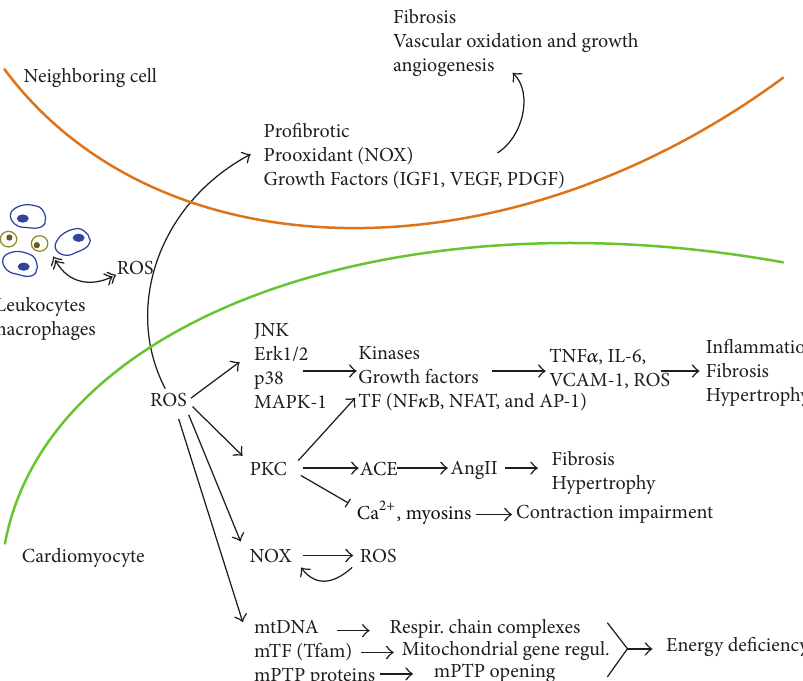
Figure 1: Paracrine and autocrine effects of ROS in DCM. ROS may be secreted from cardiomyocytes to induce responses in remote (inflammatory) and neighboring (vascular, endothelial, and fibroblast) cells. Within the cardiomyocytes, ROS could also influence different cytosolic (MAPK, PKC, and NOX) and mitochondrial mediators. mtDNA, mTF, and mPTP mean mitochondrial DNA, mitochondrial transcription factors, and mitochondrial permeability transition pores,